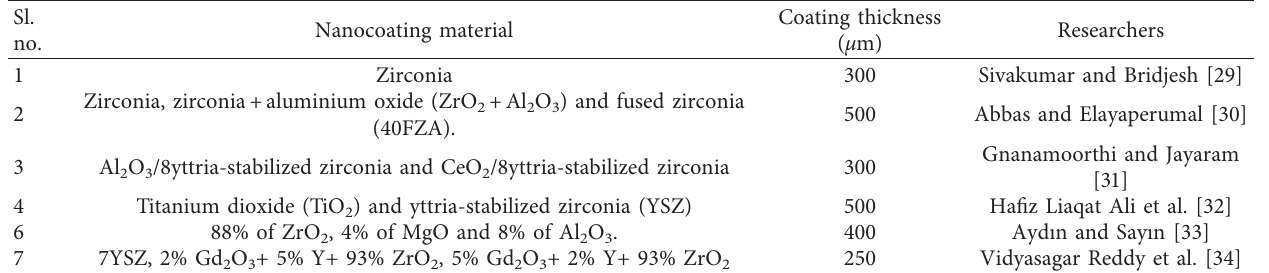
Table 1: Studies on nanocoating materials and thickness.